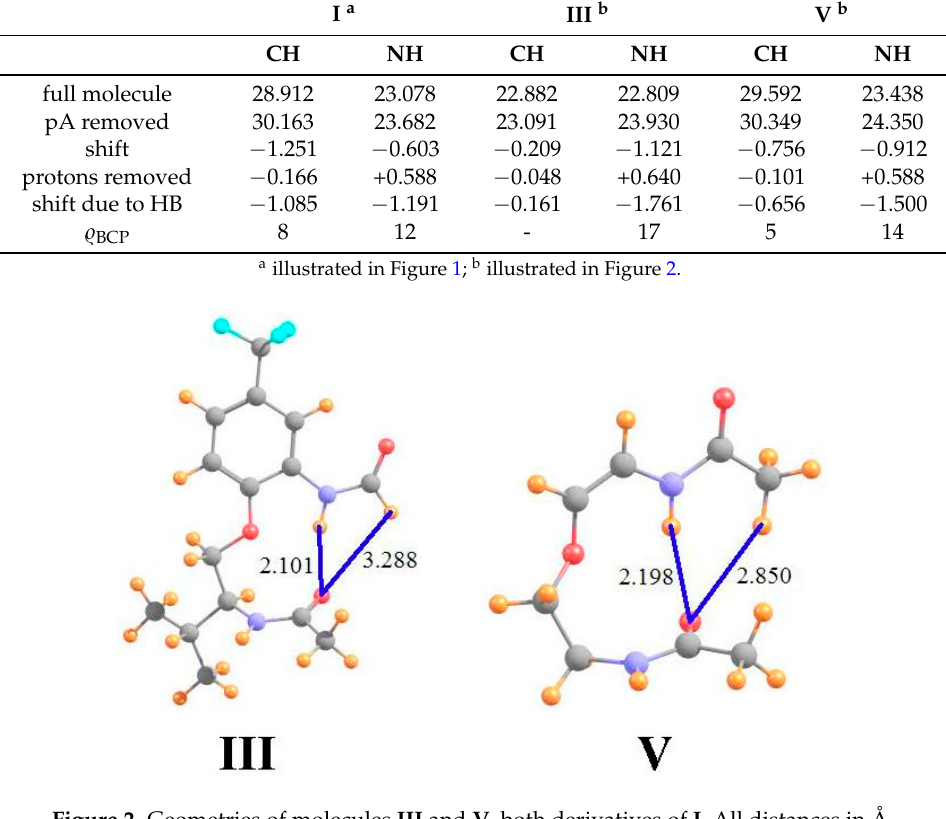
Figure 2. Geometries of molecules III and V , both derivatives of I . All distances in Å.